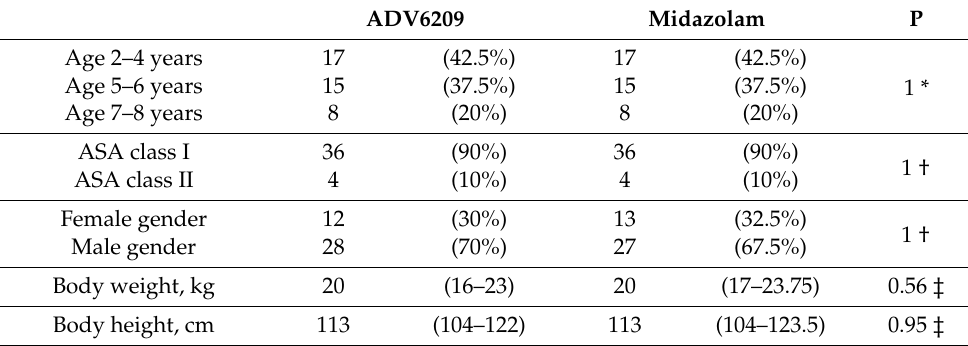
Table 1. Patient-related data.